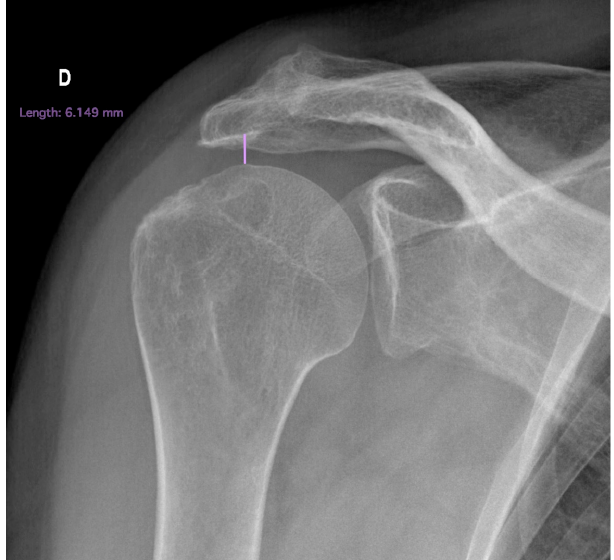
Figure 3. Superiorly migrated head of humerus.